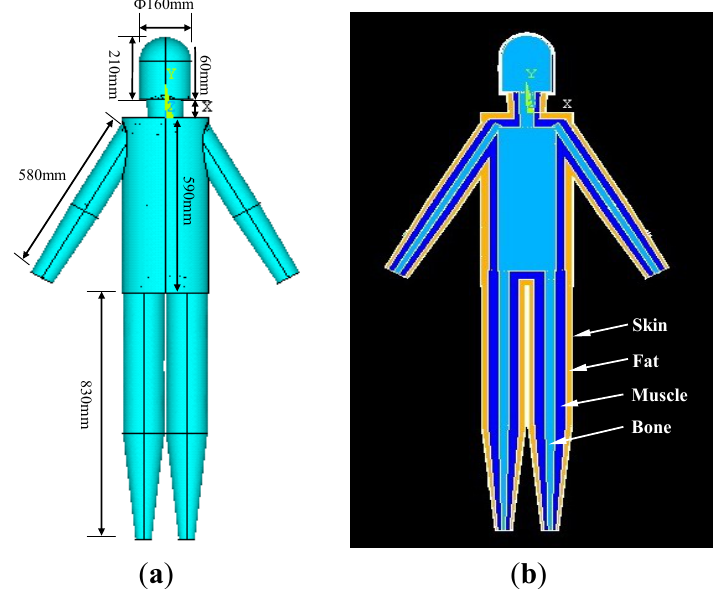
Figure 1. The 3-D view ( a ) and the internal structure ( b ) of the whole body